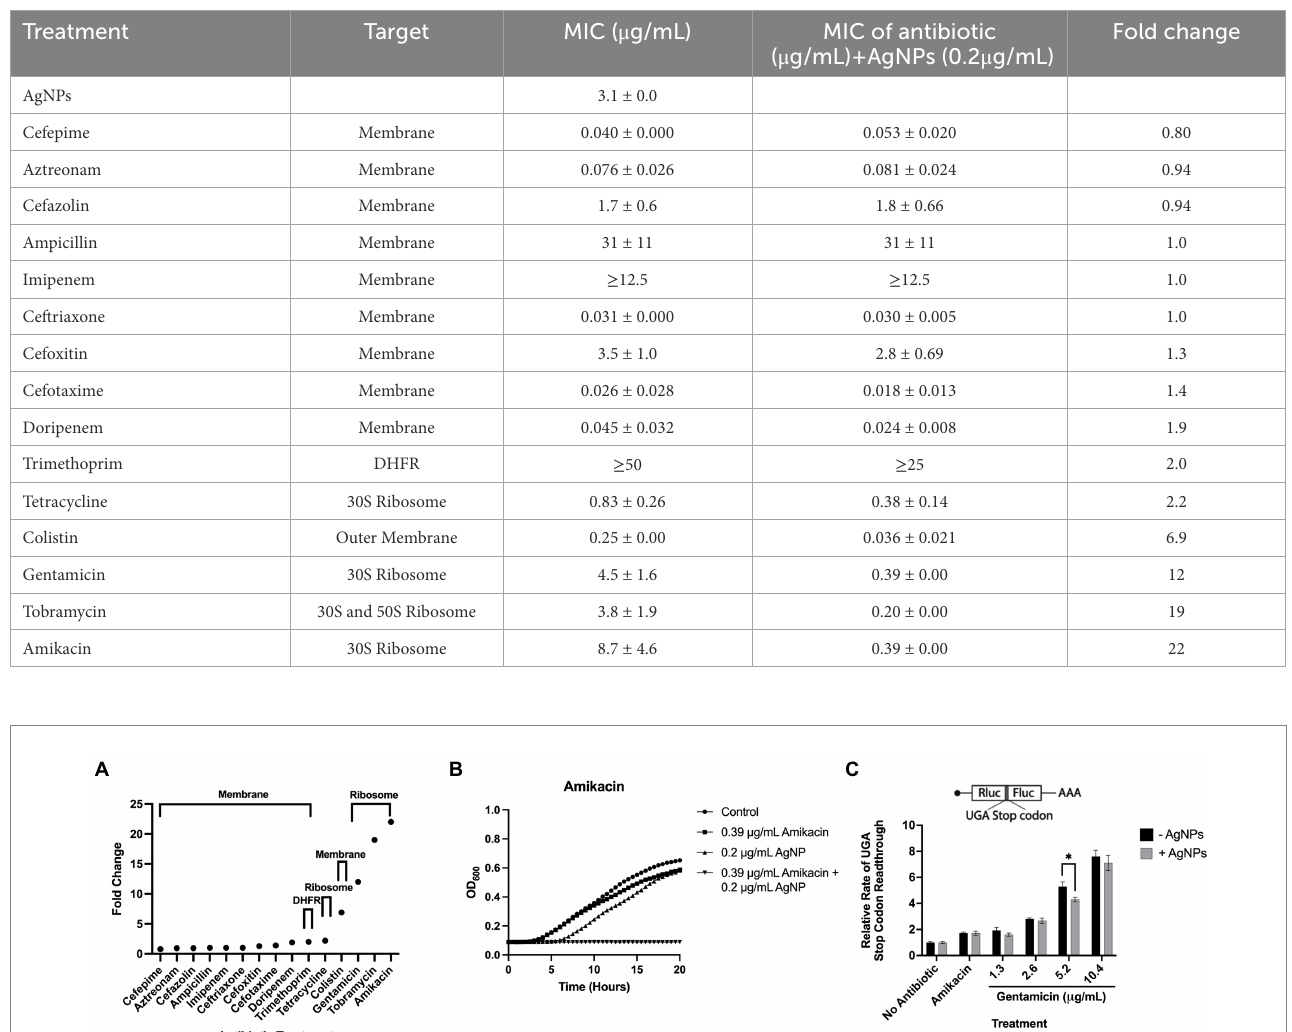
TABLE 2 AgNPs synergize with antibiotics against E. coli .